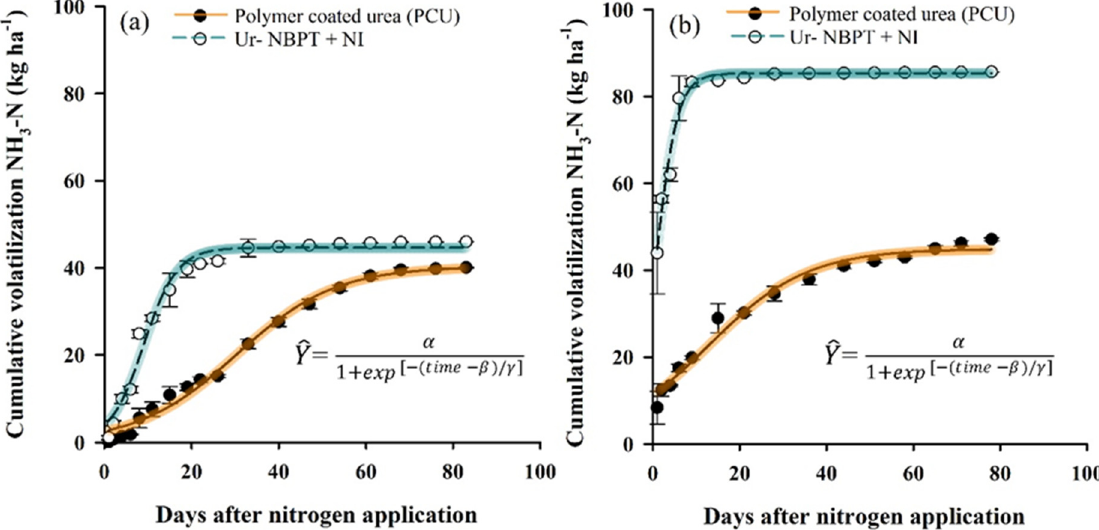
Figure 5. Cumulative volatilization of NH 3 -N after topdressing applications of the separate granules PCU and Ur-NBPT + NI for clayey soil at a rate of 200 kg ha − 1 of N ( a ) and for sand soil at a rate of 150 kg ha − 1 of N ( b ). Data with overlapping vertical bars with 95% confidence interval in the curve. Table 3. Nonlinear regression parameters adjusted (logistic model) for NH 3 -N volatilization cumu- lative losses of the separate granules PCU and Ur-NBPT + NI and the increase of NH 3 -N emission in relation to urea for clayey and sandy soils.